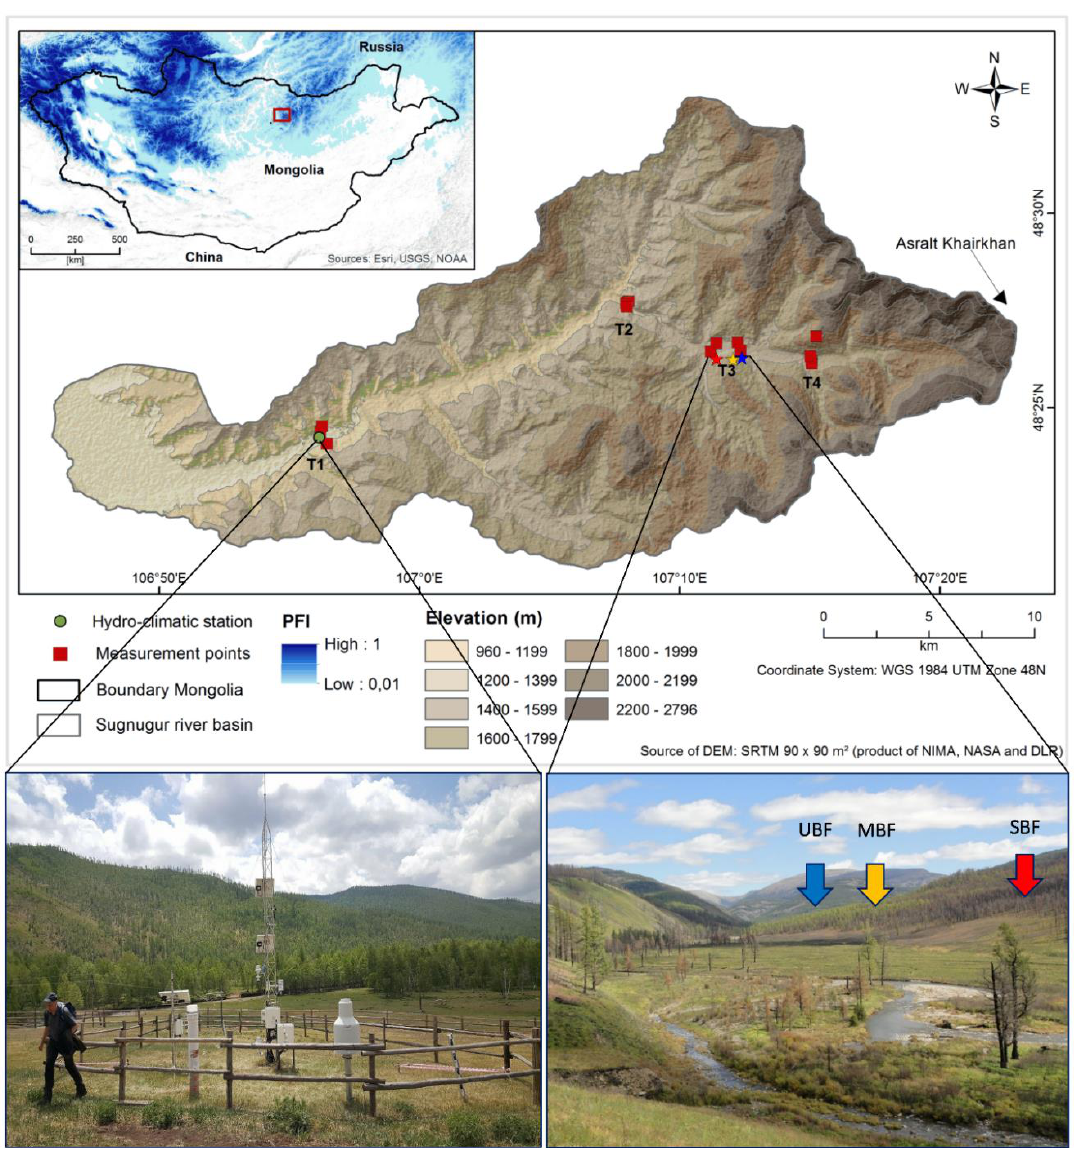
Figure 1. The locations of study area and in situ measurements. Photographs show the hydro-climatic station near the valley entry and unburned (UBF), moderate burned (MBF), and severely burned (SBF) forests on the same north-facing slope in the upper valley. The inset image illustrates the permafrost favorability index (PFI) on a global scale [34]. Measurement points indicate the locations of biomass, accumulated snow depth, thermal conductivity, and ground surface temperature (GST) measurements as cross-valley transects (on south- and north-facing slopes and in valley bottom) (T1–T4). Table 1. List of abbreviations used in the study.